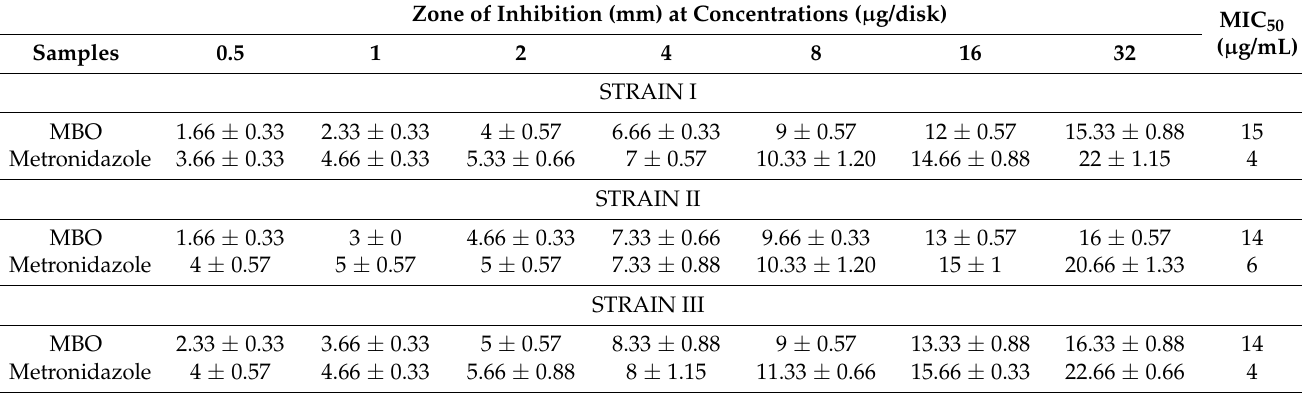
Table 3. In vitro antibacterial activity of MBO against three clinical strains of H. pylori using disc- diffusion method (values expressed as mean + SEM ( n = 3). Zone of Inhibition (mm) at Concentrations ( µ